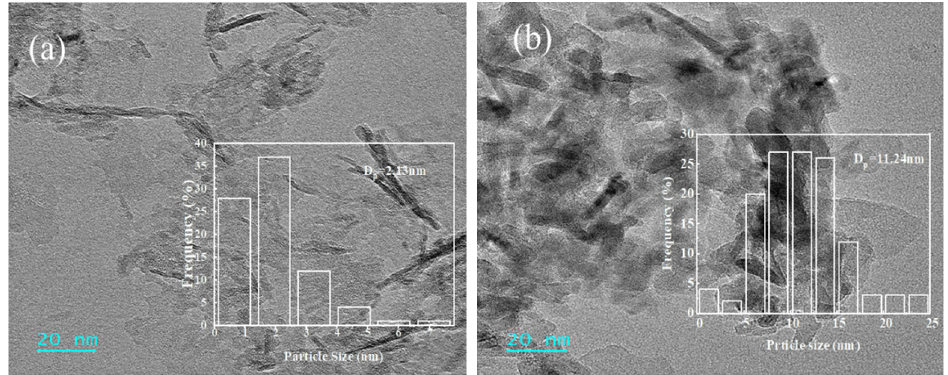
Figure 3. TEM images and particle size distribution of Ni 20 Al ( a ) and IM-NiAl catalysts ( b ).